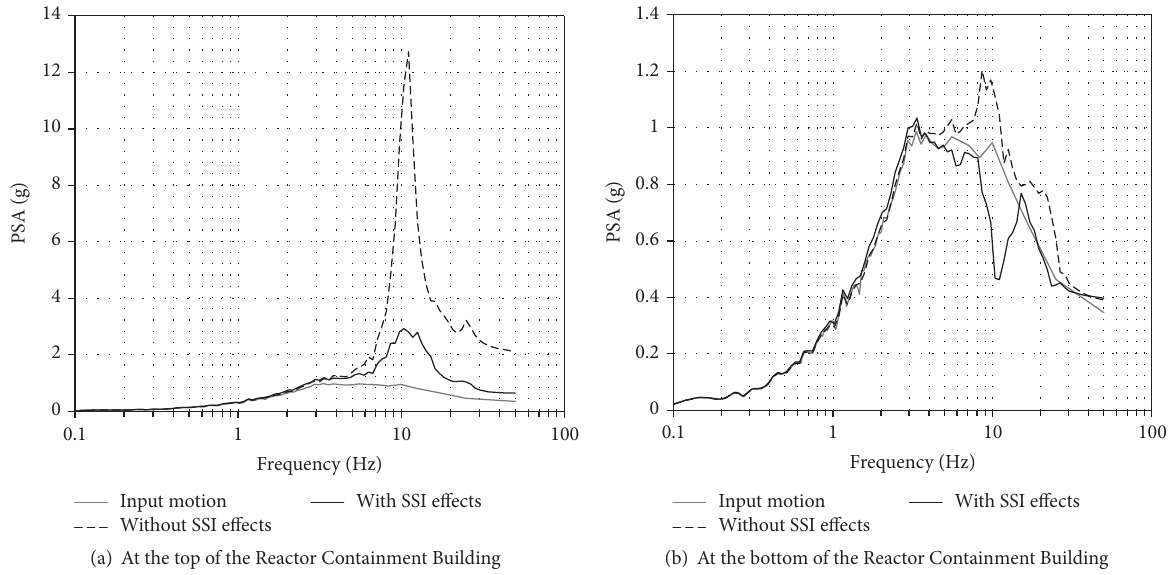
Figure 18: Comparison of the response spectral acceleration with and without SSI effects under vertical excitation.